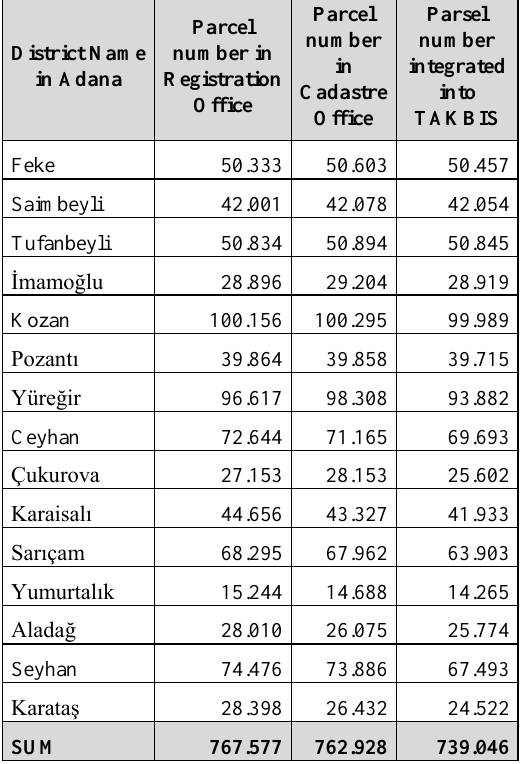
Table 1. Parcel numbers in Adana. (TKGM, 2016b)